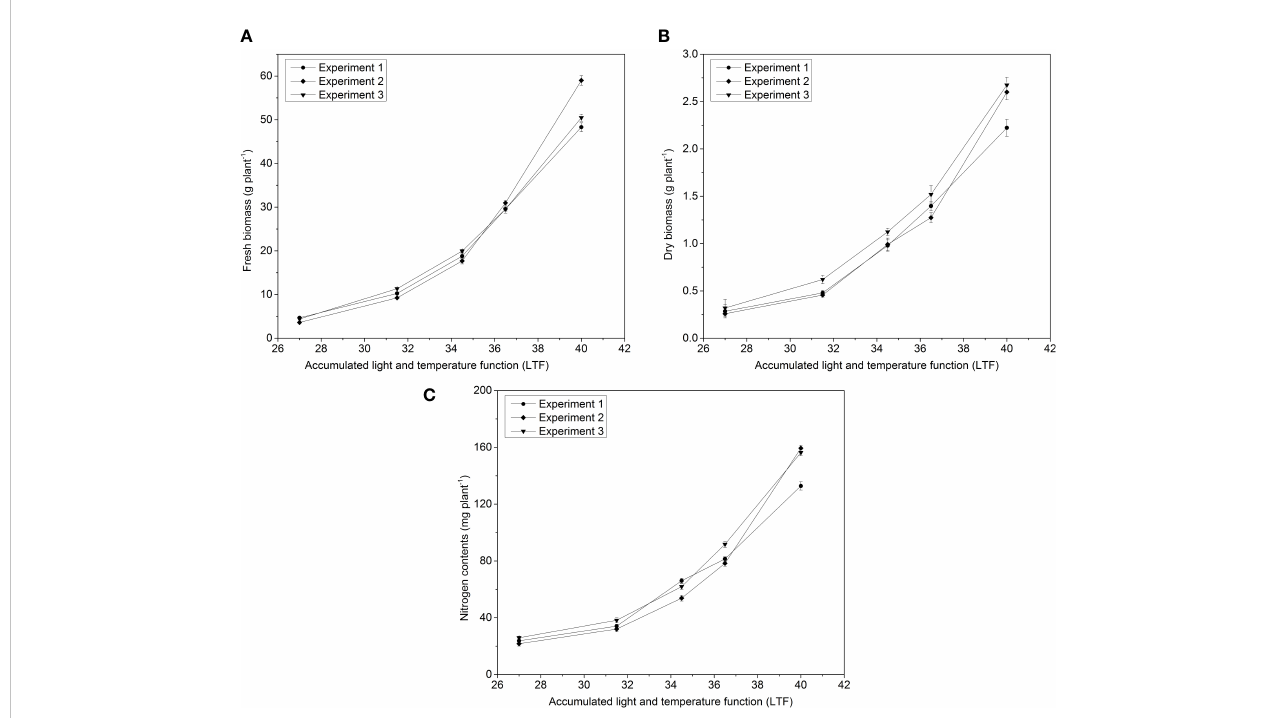
FIGURE 3 The changes of (A) plant FW, (B) plant DW, and (C) N contents with changing LTF in pakchoi under different N applications in three